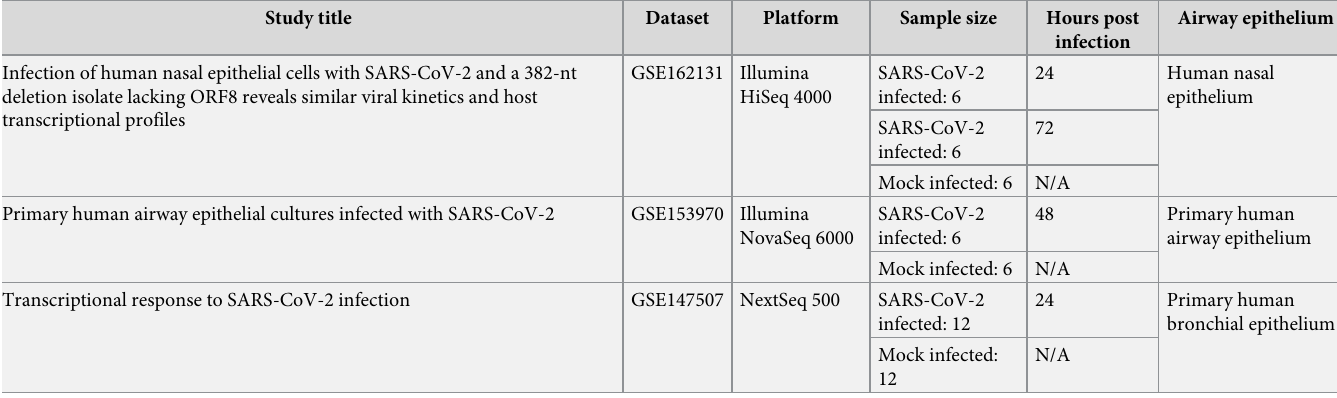
Table 1. Detailed information regarding the three selected studies associated with